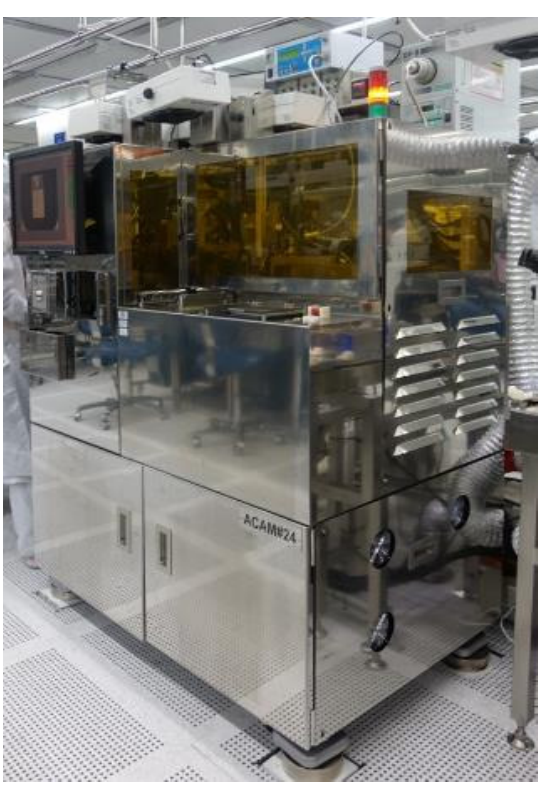
Figure 2. Auto core adhesion mounting machine.